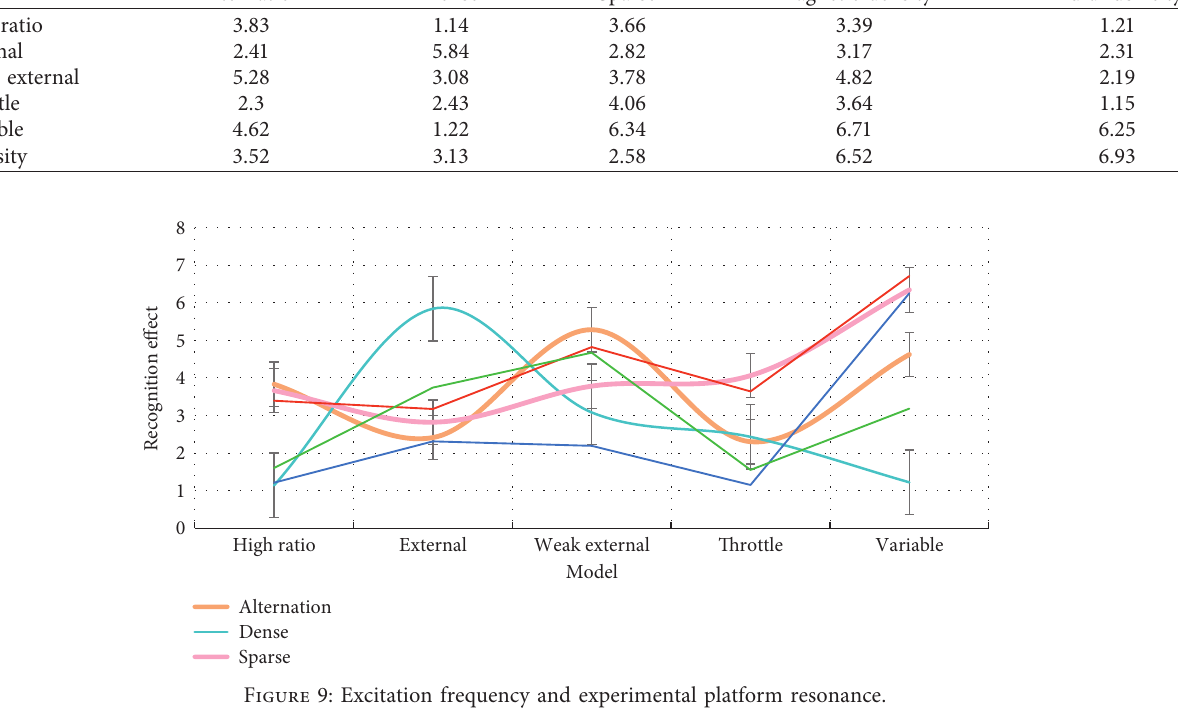
Figure 9: Excitation frequency and experimental platform resonance.